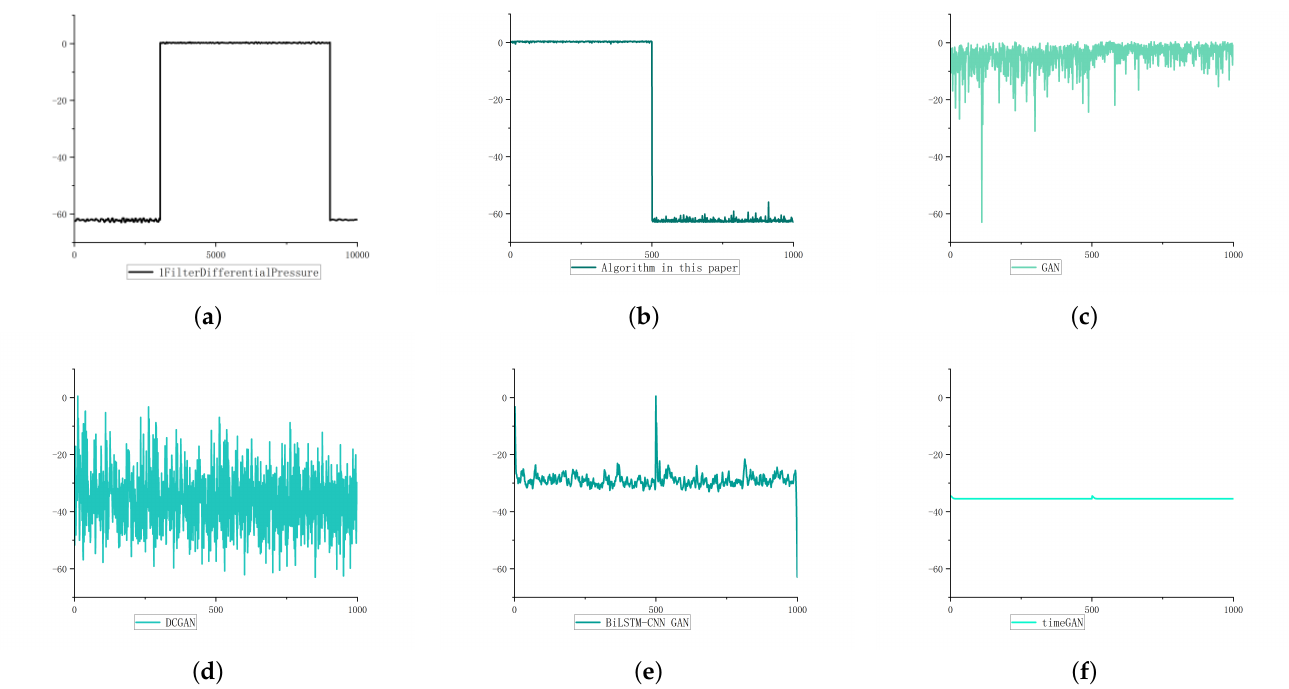
Figure 8. ( a ) Original data of the 1filterdifferentialpressure feature of the real underlying business dataset of the oil depot; ( b ) generation results of the algorithm in this paper; ( c ) generation results of GAN; ( d ) generation results of DCGAN; ( e ) generation results of BiLSTM-CNNGAN; ( f ) generation results of TimeGAN.